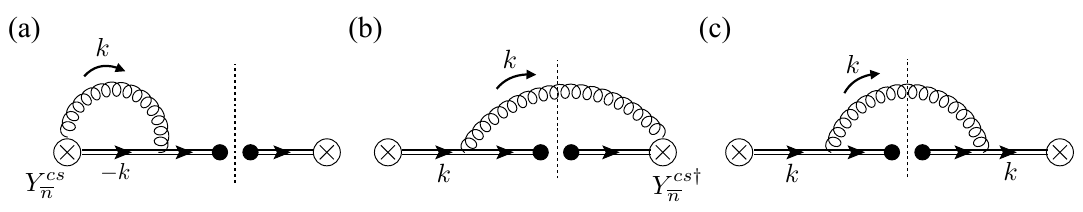
. Double lines J/Q